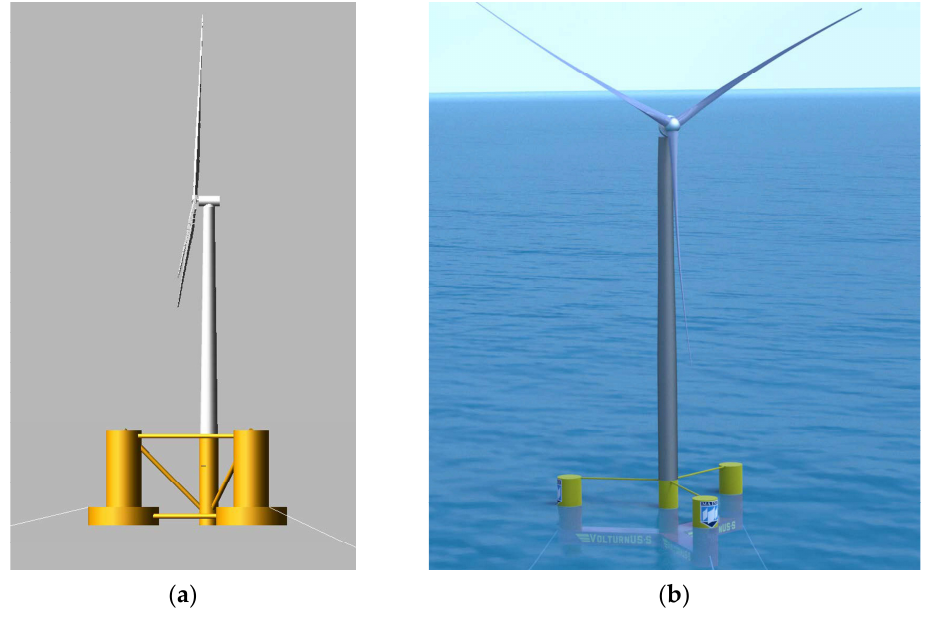
Figure 1. ( a ) OC4 DeepCWind Semi-submersible for NREL 5 MW Wind Turbine, reprinted from [3]; and ( b ) UMaine VolturnUS-S Semi-submersible for NREL 15 MW Reference Wind Turbine, reprinted from [4].